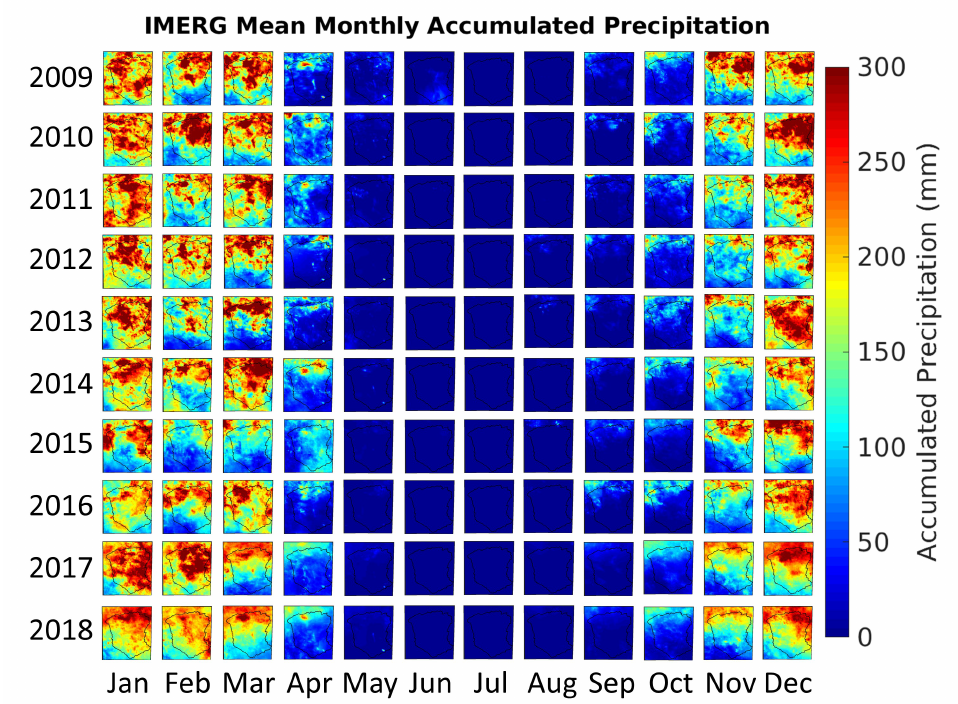
Figure 8. Spatial comparisons of Integrated Multi-satellitE Retrievals for Global Precipitation Mea- surement (IMERG) mean monthly accumulated precipitation for